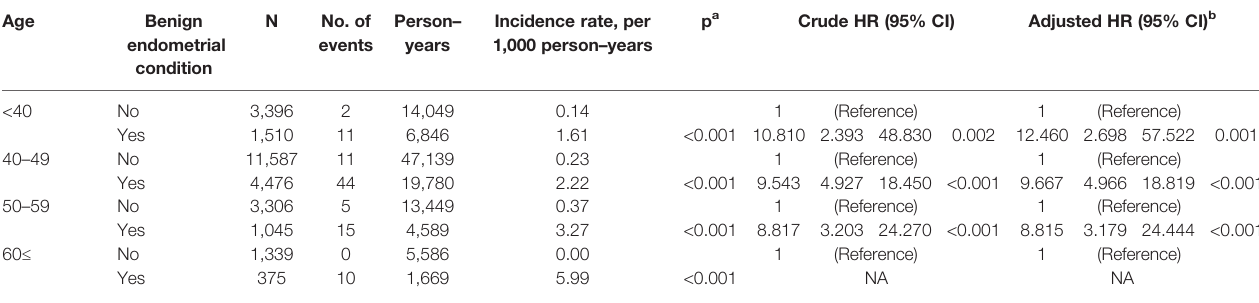
TABLE 3 | Univariate analysis and multivariable Cox regression analysis of endometrial cancer risk related to benign endometrial condition in patients treated with tamoxifen. Age Benign endometrial